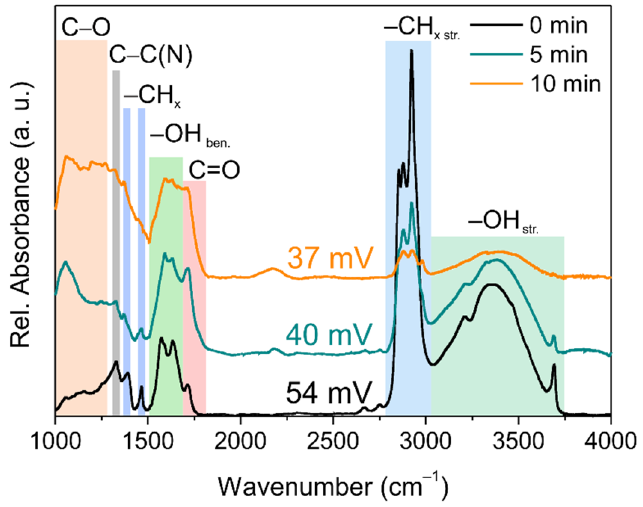
Figure 2. FTIR spectra of the pristine H-DND (0 min) and H-DND irradiated for 5 and 10 min.